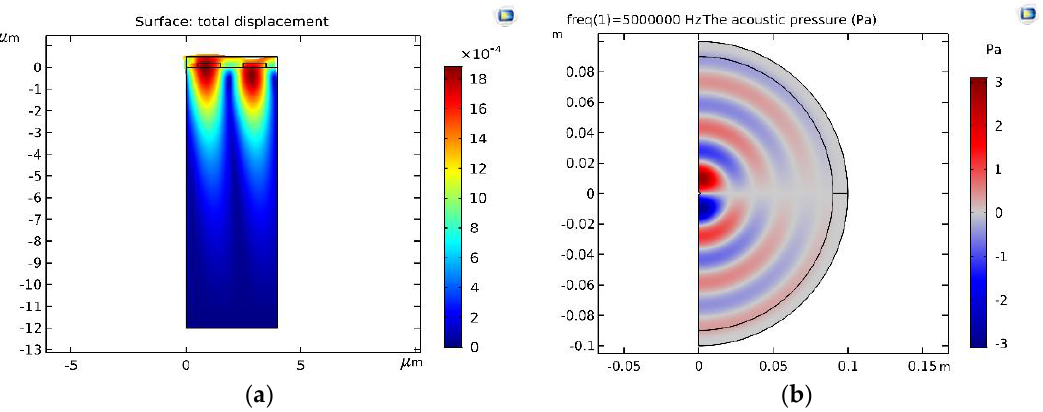
Figure 9. ( a ) Probe simulation by the finite-element method; ( b ) acoustic pressure.